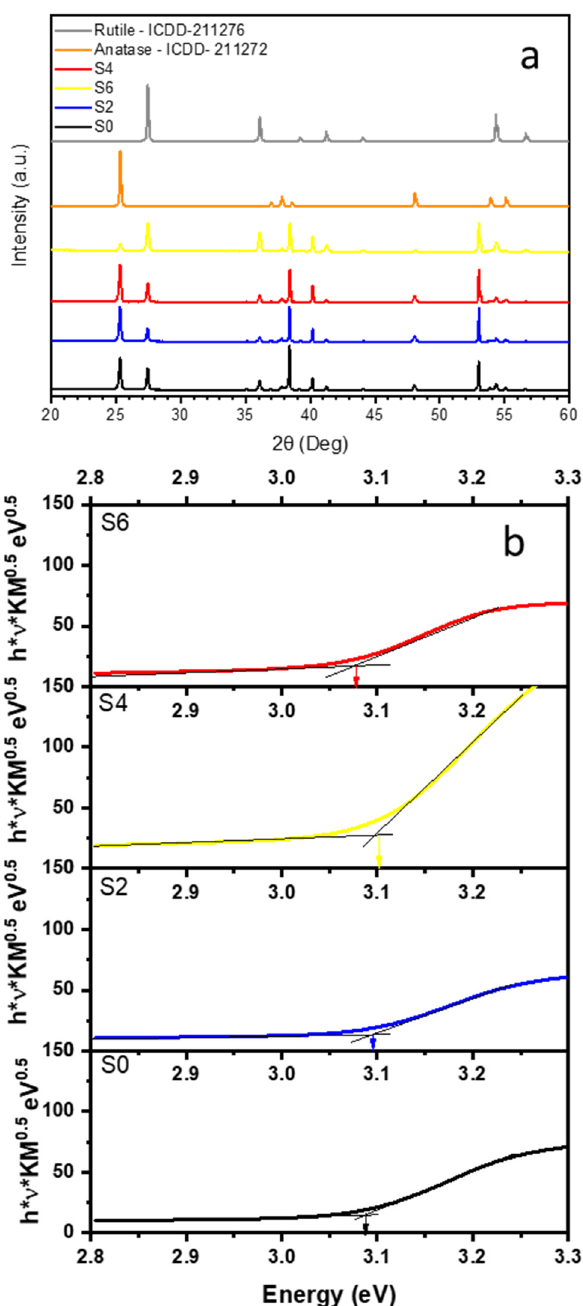
Figure 5. ( a ) XRD pattern of samples S0, S2, S4 and S6 obtained at various nickel sulfate concentrations in the electrolyte. ( b ) UV-vis-NIR diffuse reflectance spectra (DRS) for some representative TiO 2 samples as Tauc-plots of the Kubelka–Munk transform. Table 1. Sample labelling, corresponding NiSO 4 concentration in the electrolyte, anatase/rutile weight fraction, band-gap energy (E BG ), conduction band edge (CB edge ).